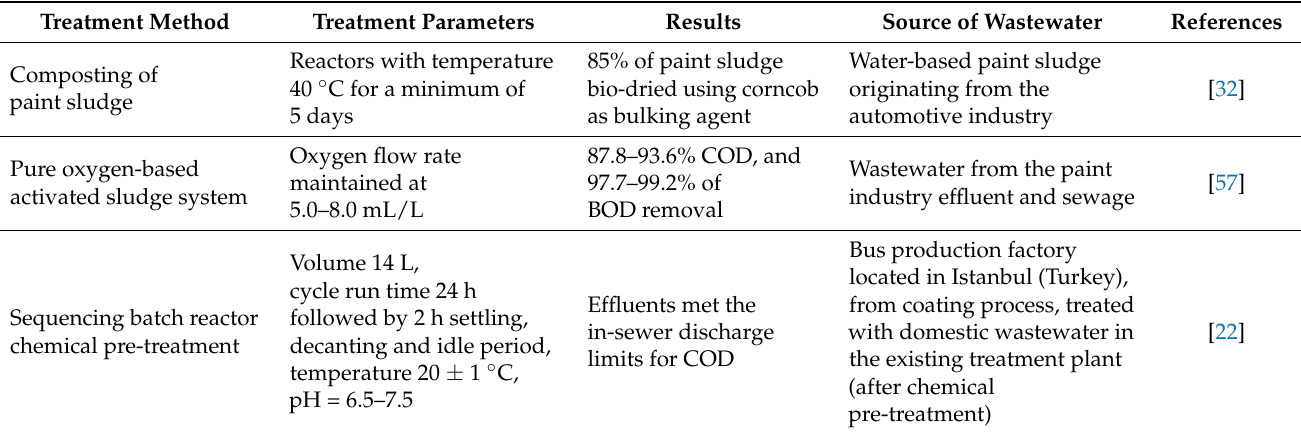
Table 2. Biological treatment methods for paint industry